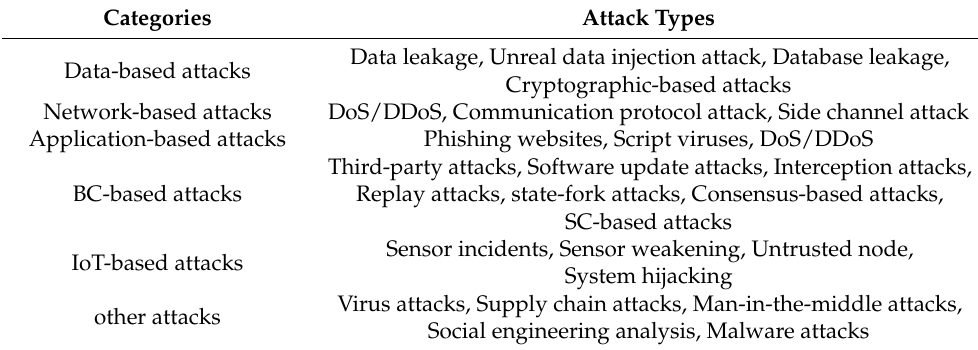
Table 4. Attack types in the BC traceability.